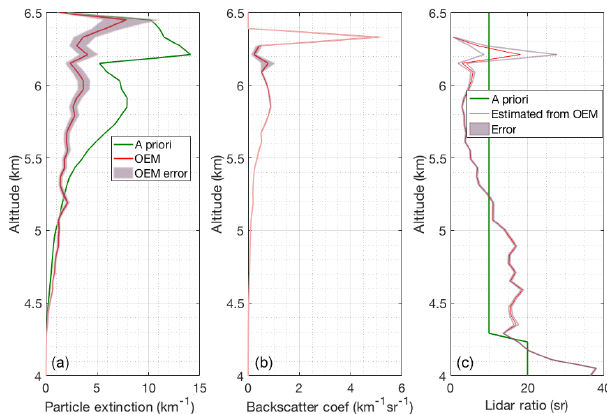
Figure 21. Same as Fig. 16 but for 21 June 2011 with the presence of a lower level